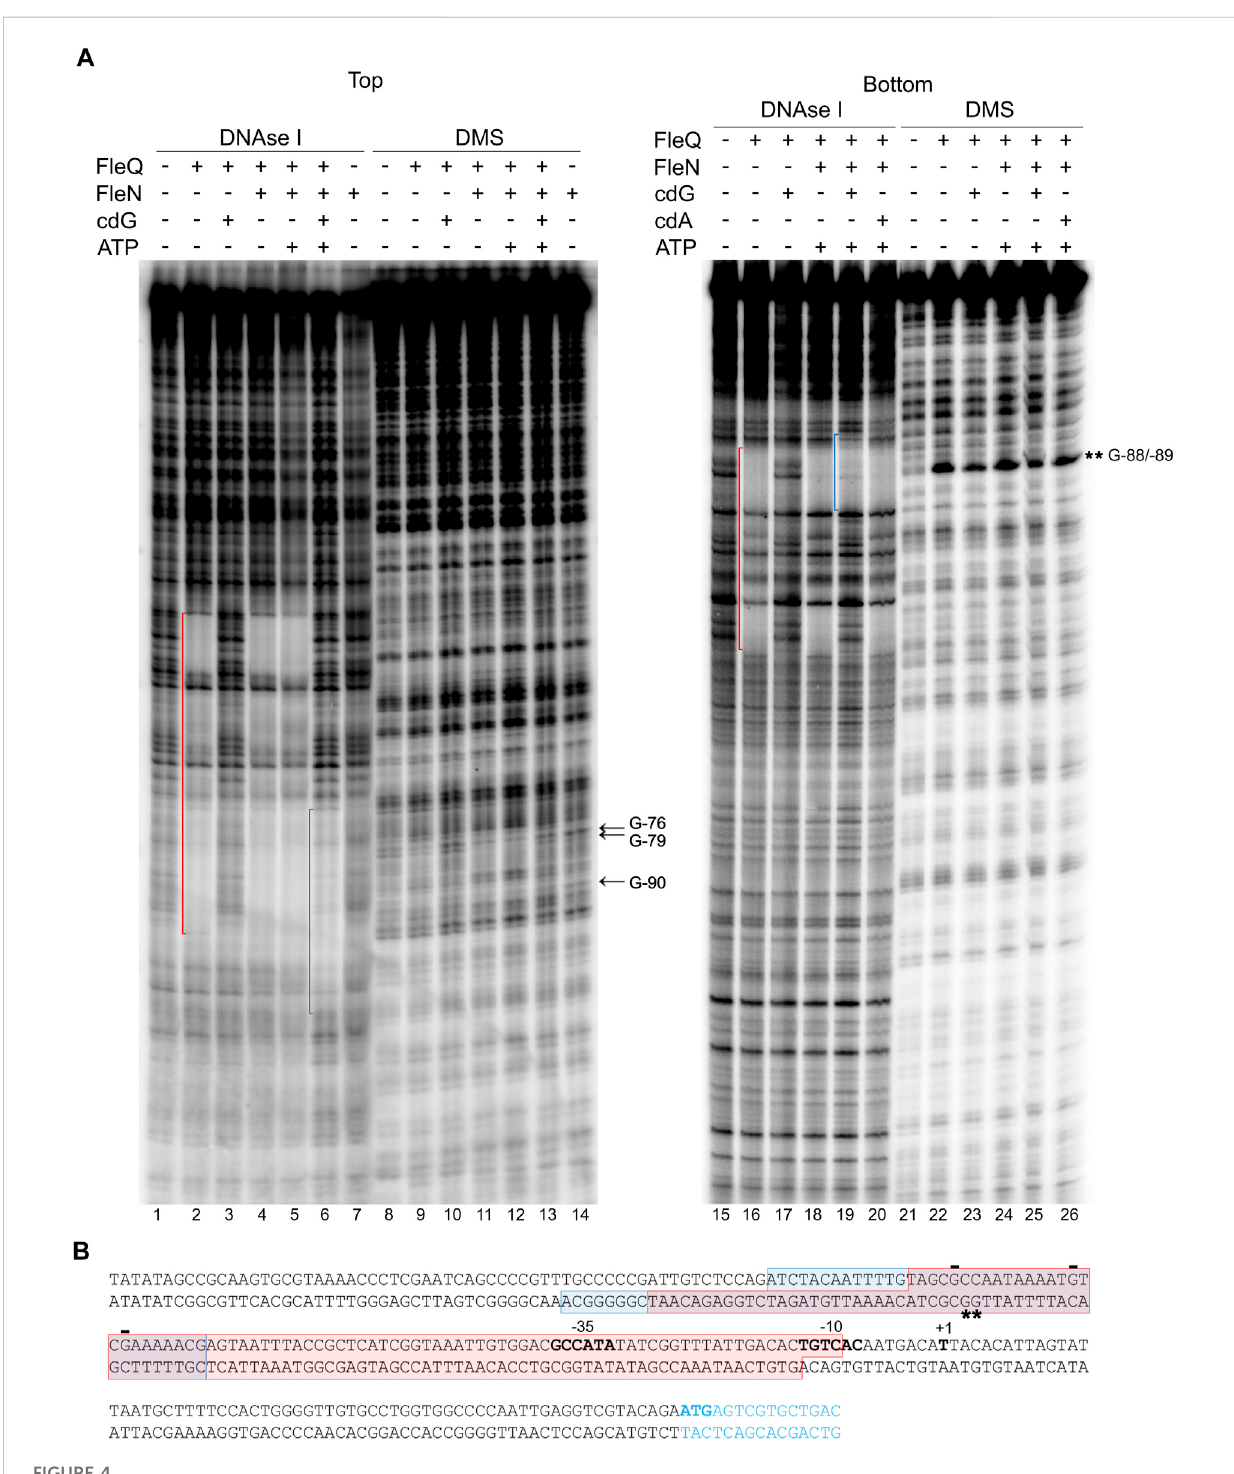
FIGURE 4 Identi fi cation of the FleQ-FleN complex binding site at the wss promoter by footprinting analysis. (A) DNAse I and DMS footprint. DNA probes correspondingtothe wssA upstreamregion5 ’ end-labeledoneitherthetoporthebottomstrandwerepreparedandincubatedwithout(lanes-)andwith FleQ (0.5 µm) and/or FleN (0.5 µm), ATP (0.25 mM) and c-di-GMP (0.25 mM). After partial digestion with DNase I or treatment with DMS and partial digestion with piperidine, the DNAs were subjected to urea-PAGE. Nucleotide sequences protected by FleQ and FleQ-FleN in the absence of c-di- GMP (red) or by the FleQ-FleN complex in the presence of c-di-GMP (blue) are indicated. Protected (arrow) and hyperreactive (*) nucleotides are also indicated. (B) LocalisationoftheFleQandFleQ-FleNbindingsitesatthewsspromoter.TheboxesindicatetheregionsprotectedfromDNAseIbyFleQor FleQ-FleN(red)andFleQ-FleNinthepresenceofc-di-GMP(blue)inthetopandbottomstrands.The-10and-35regionsandthe wss transcriptionalstart site are in bold. *, indicates hyperreactivity and -,